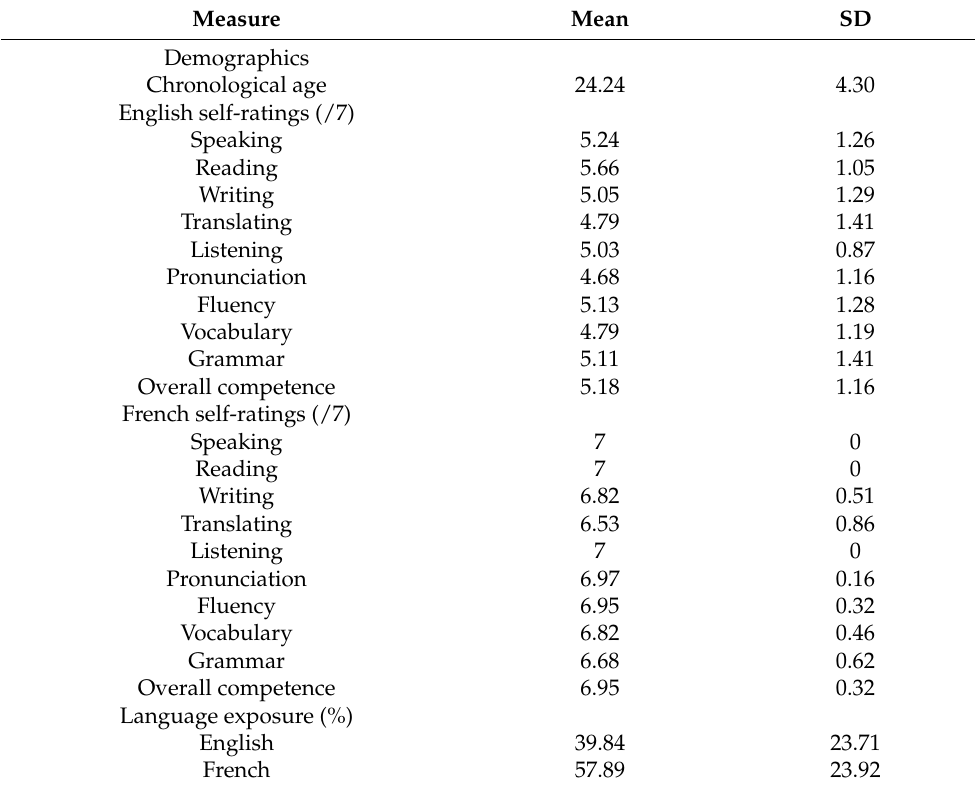
Table A2. Full participant characteristics (Experiment 2). Self-ratings were collected on a 1–7 scale